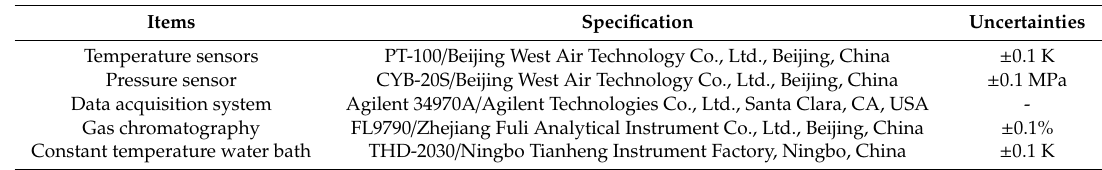
Table 1. Experimental devices and specifications.